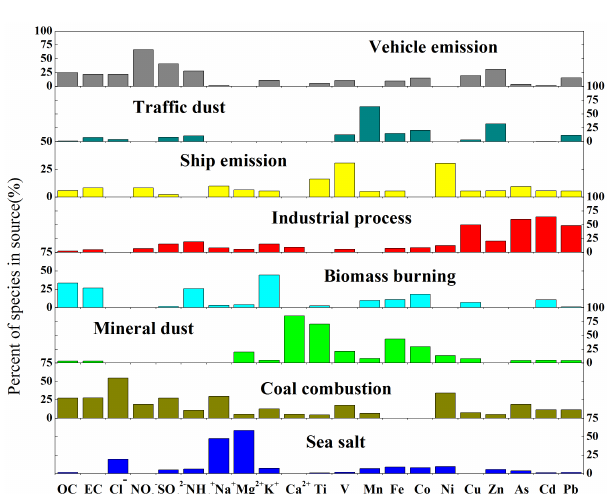
Figure 4. The contribution profiles of eight sources identified by PMF